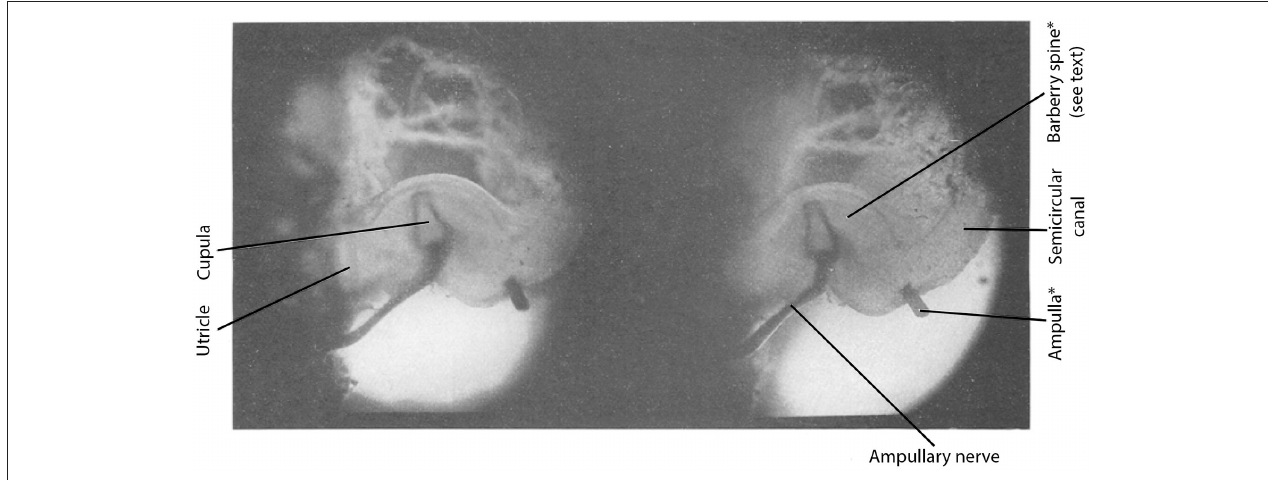
FIGURE 1 | Stereo image of an ink-stained cupula in the intact semicircular canal ampulla of a freshly-produced pike labyrinth [Note by the translators: the two labels indicated by * (i.e., Ampulla * and Barberry spine * ) were erroneously placed in the original paper and should be swapped]